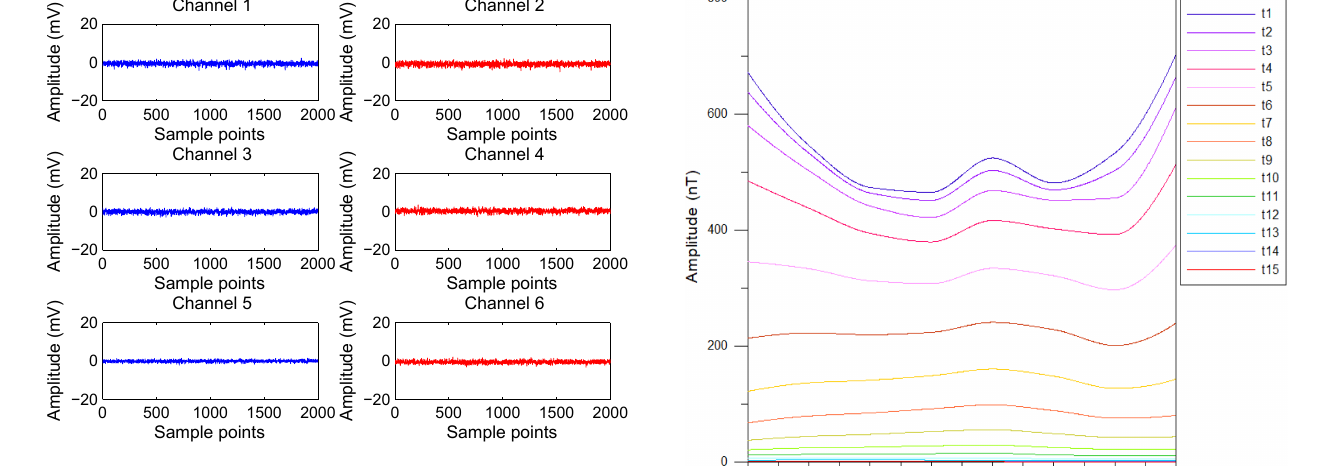
Figure 14. Background noise of receiver.